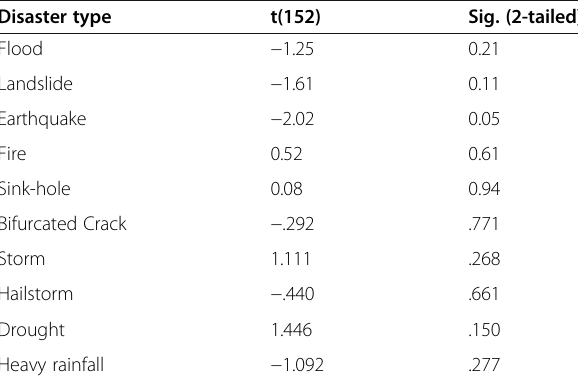
Table 6 t-test result for gender-based opinion on level of danger during major